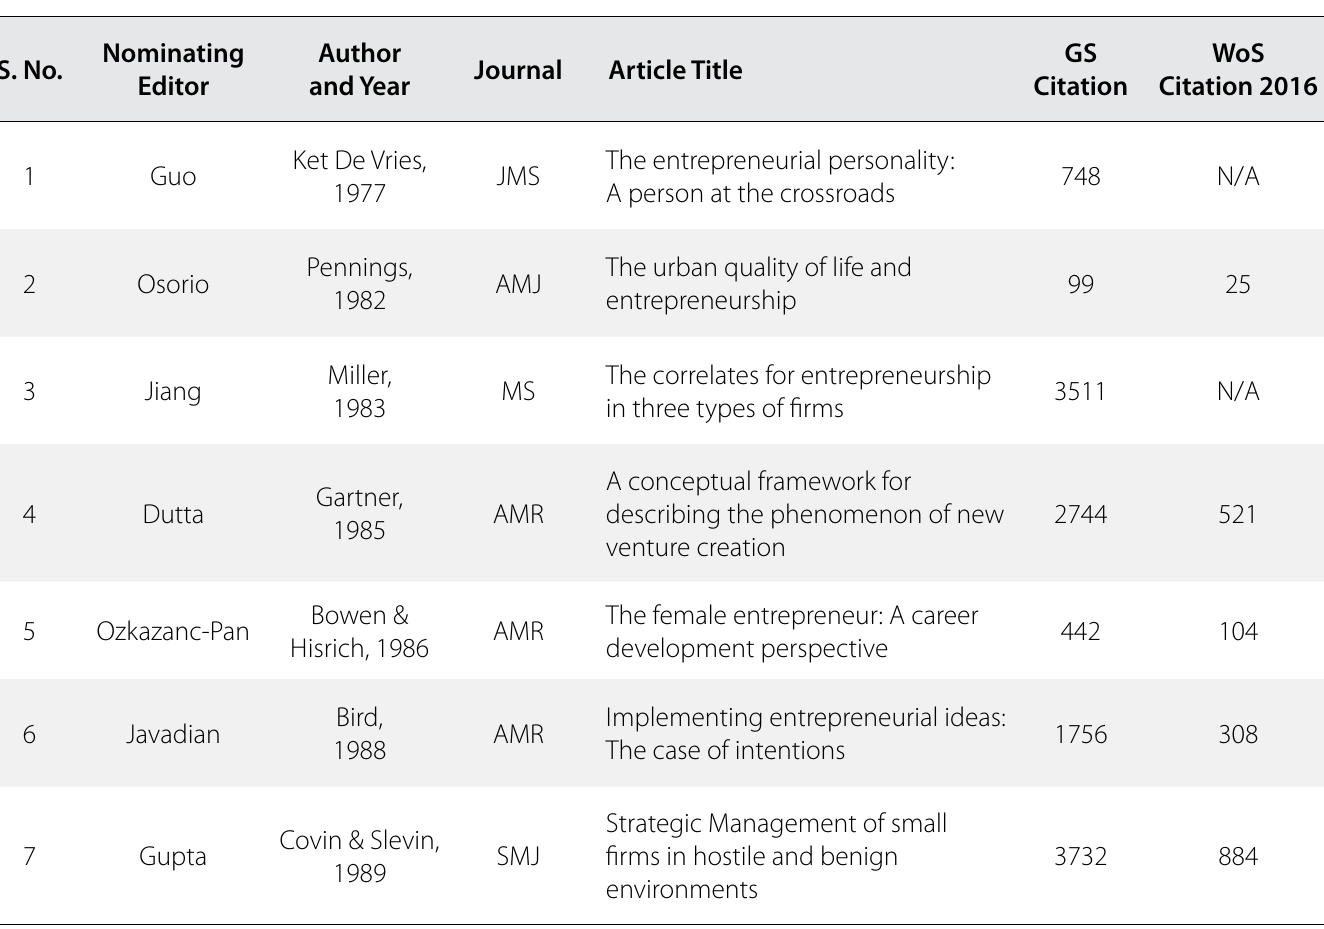
Table 1. Classic Entrepreneurship Papers (published during 1970s and